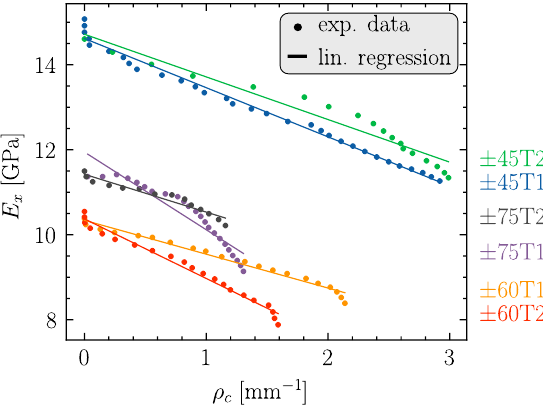
Figure 8. Relationship of the experimentally determined stiffness and crack density up to saturation. For the ± 45° and ± 60° specimen, the stiffness degradation correlates linearly with the crack density. Note that the fact that the stiffness for the ± 75° specimen is higher compared to ± 60° is a result of the given ply material properties and in accordance with classical laminate